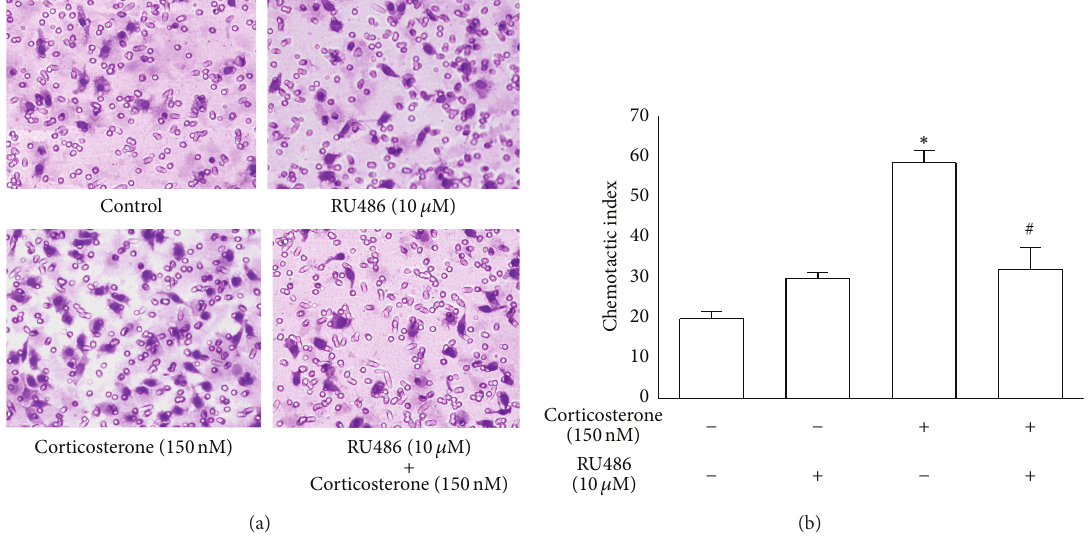
Figure 2: Effects of low concentration of corticosterone on the chemotaxis of rat peritoneal macrophages in the presence or absence of RU486. (a) Rat peritoneal macrophages were treated with vehicle diluent (ethanol) as a control group. Macrophages were treated with RU486 (10 𝜇 M), corticosterone (150nM), and RU486 (10 𝜇 M) plus corticosterone (150nM), respectively ( × 400). (b) The results were representative of five independent experiments performed on triplicate samples. ∗ 𝑃 < 0.01 versus the control group, # 𝑃 < 0.01 versus the corticosterone (150nM)